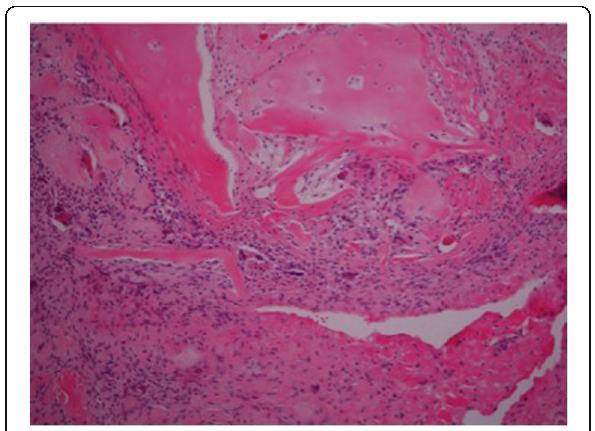
Fig. 1 High-power (40x) microscopic appearance of medial aspect of the graft, with extensive inflammatory cell infiltrates (purple nucleated